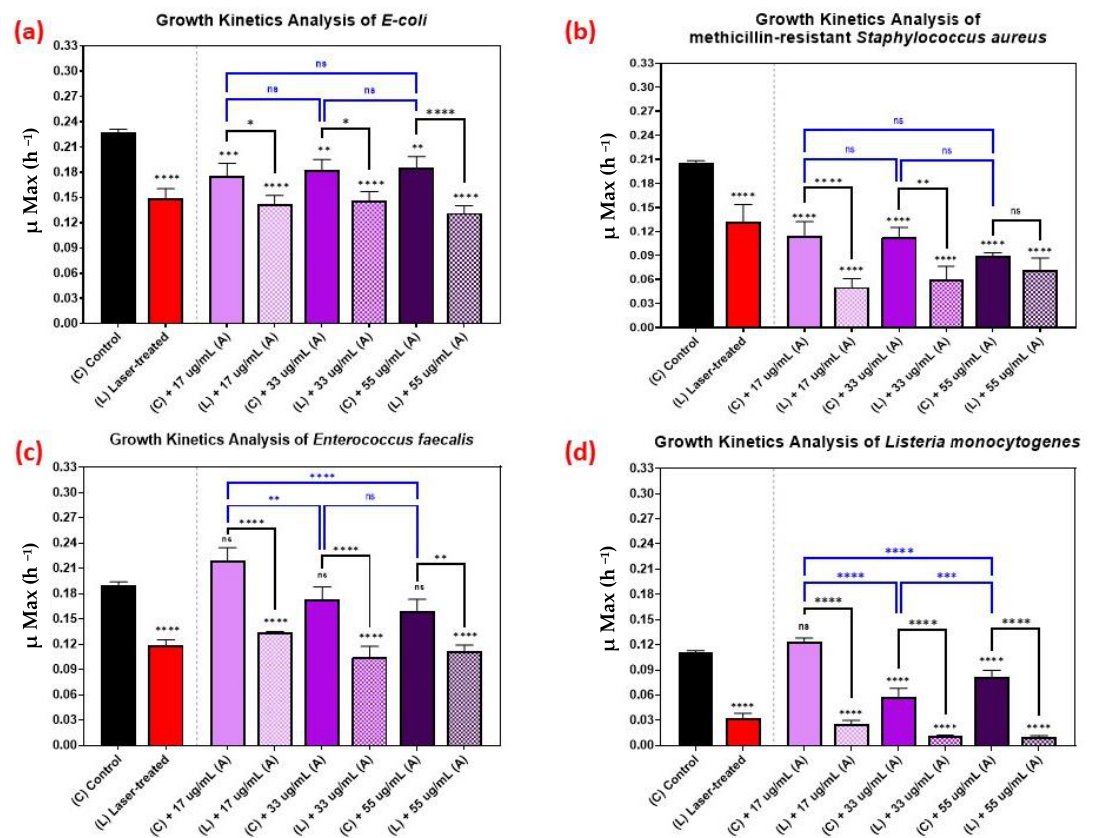
Figure 6. Bar graph of the four different bacterial pathogens: ( a ) E. coli , ( b ) Staphylococcus aureus , ( c ) Enterococcus faecalis , and ( d ) Listeria monocytogenes , comparing growth rate during the log phase of the control culture (C) with that of the bacterial cultures exposed to different treatments: laser treatment (L), AuQDs treatment (C + A), and laser + AuQDs treatment (L + A) . All four pathogens were exposed to femtosecond laser treatment with a wavelength of 400 nm and average power of 50 mW for 15 min. The cultures were exposed to AuQDs-treated sample (A) (7.8 nm average size) with concentrations of 55, 33, and 17 µg/mL. Significance was tested using ANOVA followed by Tukey testing (**** p < 0.0001, *** p < 0.001, ** p < 0.01, * p < 0.05, ns; no significance).